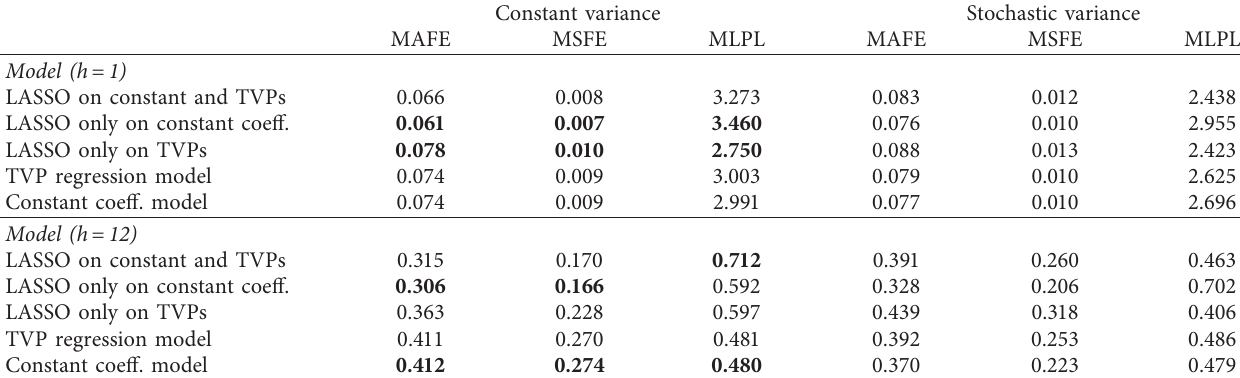
Table 10: Measures of forecast performance for log return of Brent with recursive rolling window results.